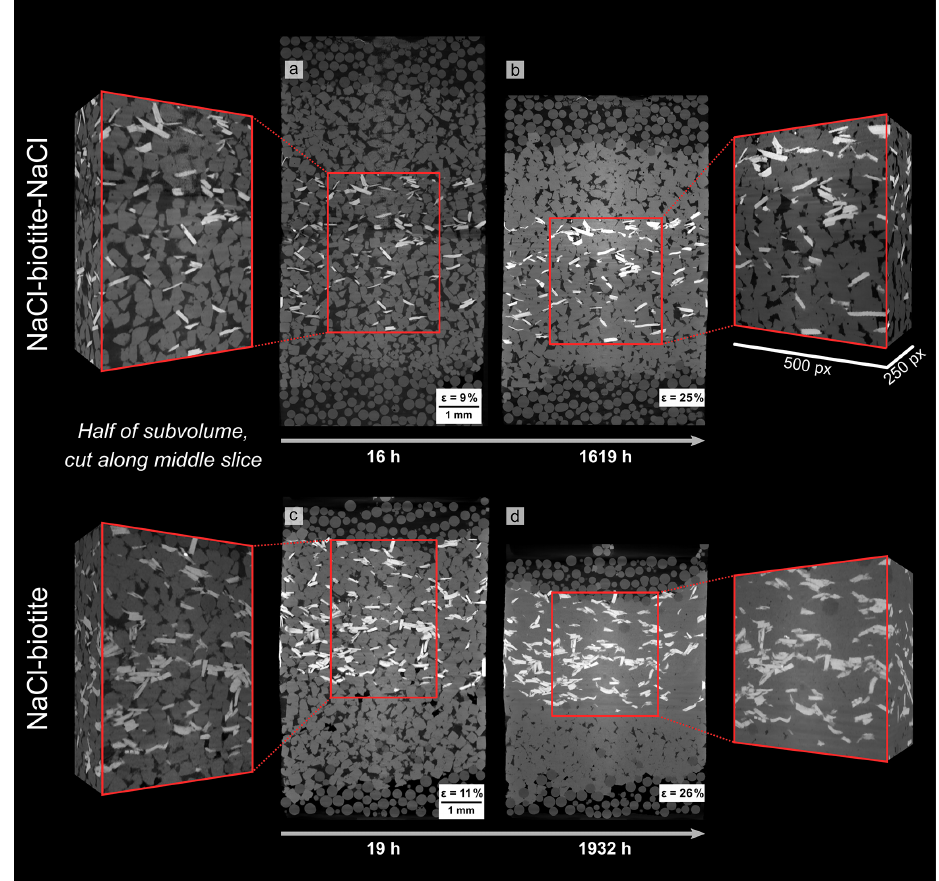
Figure A1. Location of the subvolumes used for the volumetric NaCl measurements relative to the sample. The top row shows the location of the subvolume at the beginning and the end of the experiment within the SBS sample while the bottom row shows it for the SB sample. The subvolumes are centred around a vertical slice that runs through the middle of the sample. Hence, the depicted subvolumes represent only half of the volume used for the